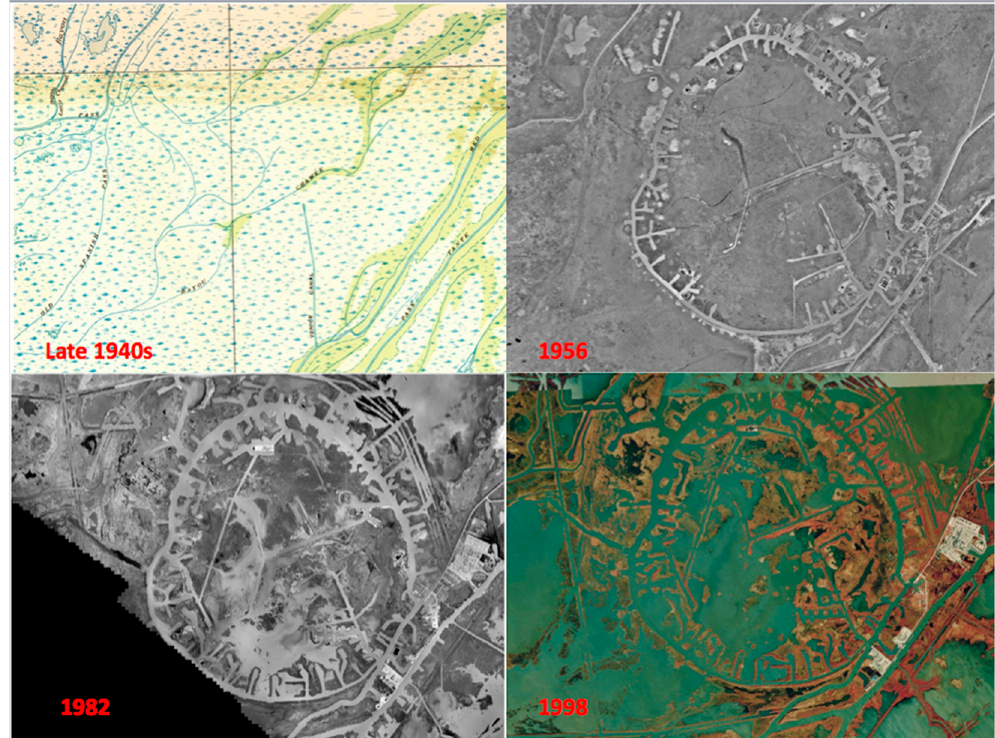
Figure 17. Images of hydrologic changes and wetland loss in the Venice field, Plaquemines Parish, Louisiana over time. This oil and gas field has been termed the “wagon wheel” because of the circular canals and spoil banks that outline the salt dome around which oil and gas containing formations were located. Note that wetland loss occurs both in the vicinity of the canals as well as throughout the area of the field. In addition to wetland loss, many of the spoil banks have subsided below water level and are no longer visible. The green highlighted channels in the 1940s are minor distributary ridges that both conveyed water and were a barrier to horizontal flow perpendicular to these ridges. (Images from USGS topographic maps (late 1940s) and Google Earth).